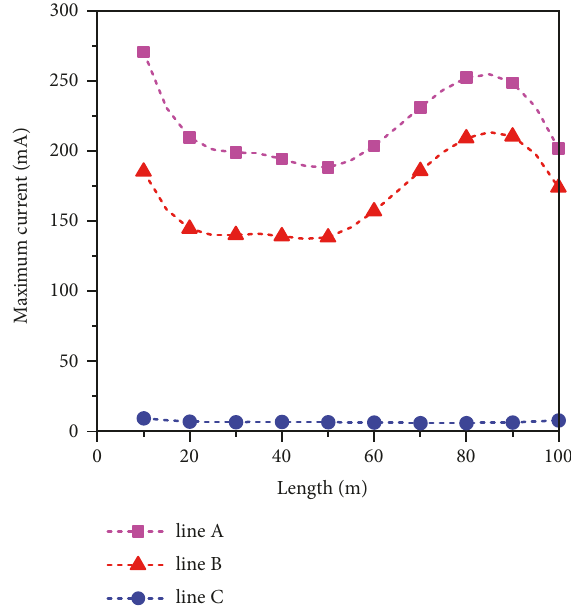
Figure 17: Maximum Currents with different conductor radii. The frequencies are 60 MHz, and radiation source heights are 1 km. Figure 18: Maximum currents with different conductor lengths. Conductor radii are 0.007